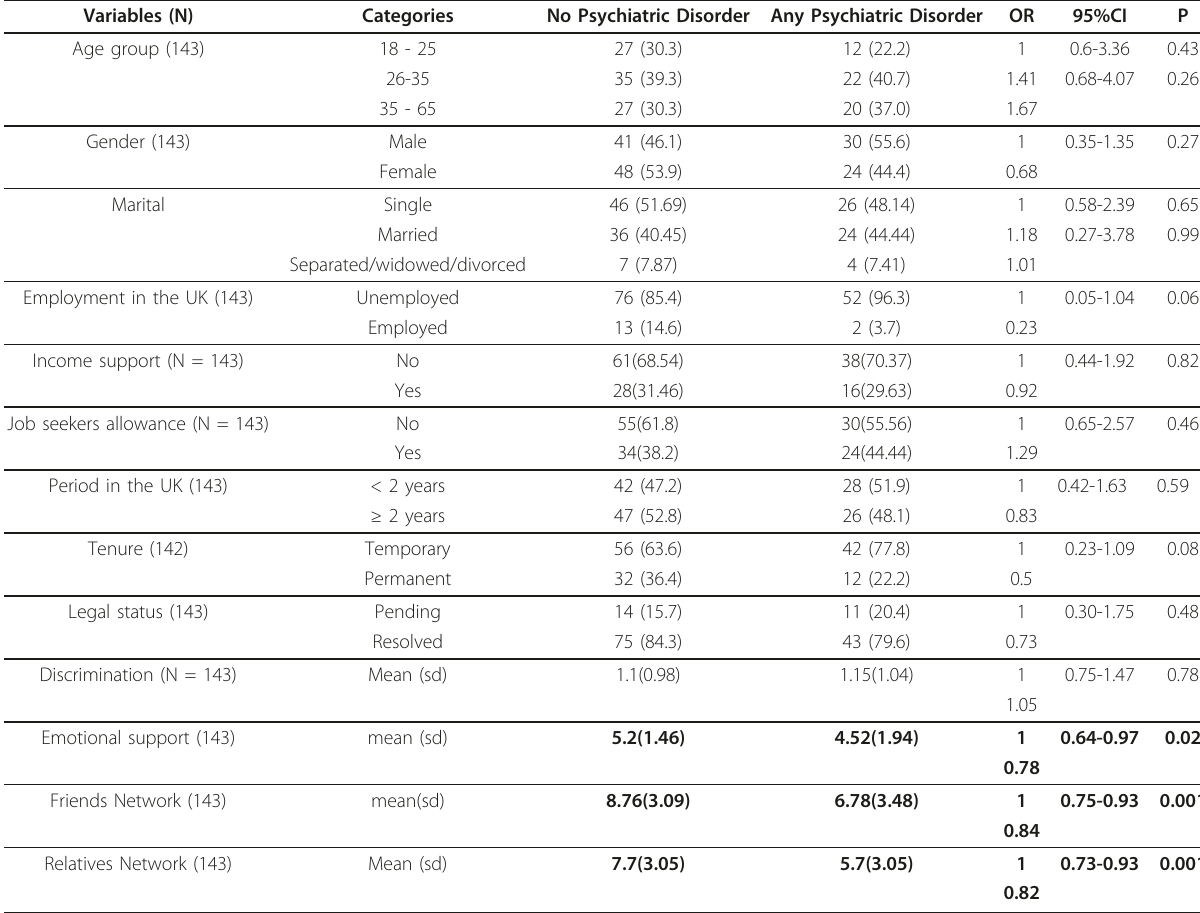
Table 2 Demographic, social, legal characteristics of those with and without any psychiatric disorder meeting ICD-10 or DSM-IV diagnostic